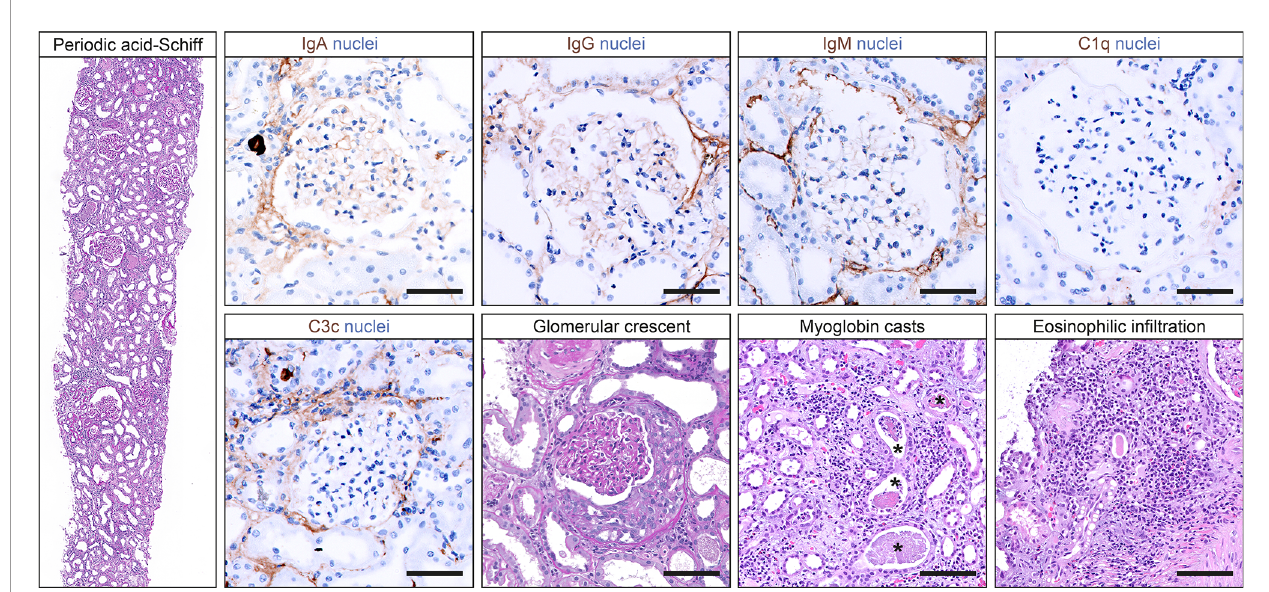
FIGURE 2 | Histopathological fi ndings in a kidney biopsy con fi rming pauci-immune crescentic GN. Representative photomicrographs of the kidney biopsy including staining for IgA (scale bar: 50 m m), IgG (scale bar: 50 m m), IgM (scale bar: 50 m m), C1q (scale bar: 50 m m), and C3c (scale bar: 50 m m); periodic acid-Schiff staining showing a glomerulus with crescent formation (scale bar: 50 m m); and hematoxylin/eosin staining with myoglobin casts (asterisks, scale bar: 100 m m) and tubulointerstitial in fl ammation with prominent eosinophilic in fi ltration (scale bar: 100 m m). C1q, complement component 1q; C3c, complement factor 3 conversion product; IgA, immunoglobulin A; IgG, immunoglobulin G; IgM, immunoglobulin M; GN, glomerulonephritis.